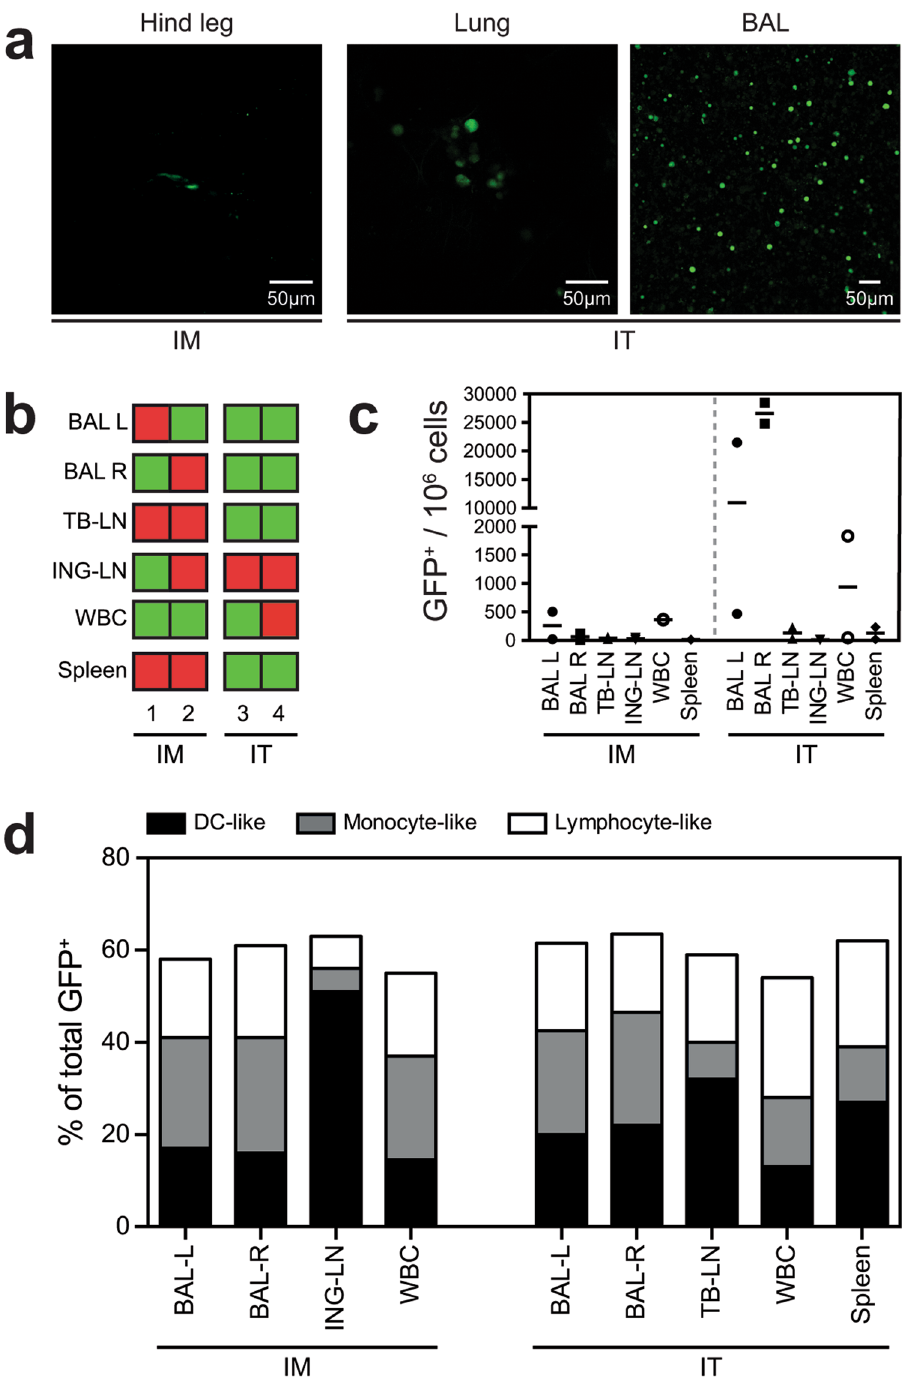
Figure 5. Detection of GFP + cells in ferrets after IM injection and IT inoculation of rMVA-GFP. ( a ) Direct detection of GFP + cells using CLSM after IM injection (left panel) or IT inoculation (middle and right panel) of 10 9 PFU rMVA-GFP, 6 HPA. Middle panel shows direct CLSM of a lung slice, whereas the right panel shows cells recovered from the lungs by BAL. Contrast of certain images was linearly enhanced using Adobe Photoshop CC. ( b ) Overview of detection of GFP + cells in BAL (left [L] or right [R] lung lobes), TB-LN, ING-LN, WBC or spleen in each individual ferret (n = 2 per group) after IM injection or IT inoculation of rMVA-GFP. Green = GFP + . Red = GFP-negative. ( c ) Frequency of GFP + cells in the respective tissues after IM injection or IT inoculation of rMVA-GFP. Number of GFP + cells per 10 6 total cells is shown, mean of two ferrets is indicated. ( d ) GFP + cells were phenotypically characterized as DC-like, monocyte-like or lymphocyte-like cells based on scatter properties of the different cell